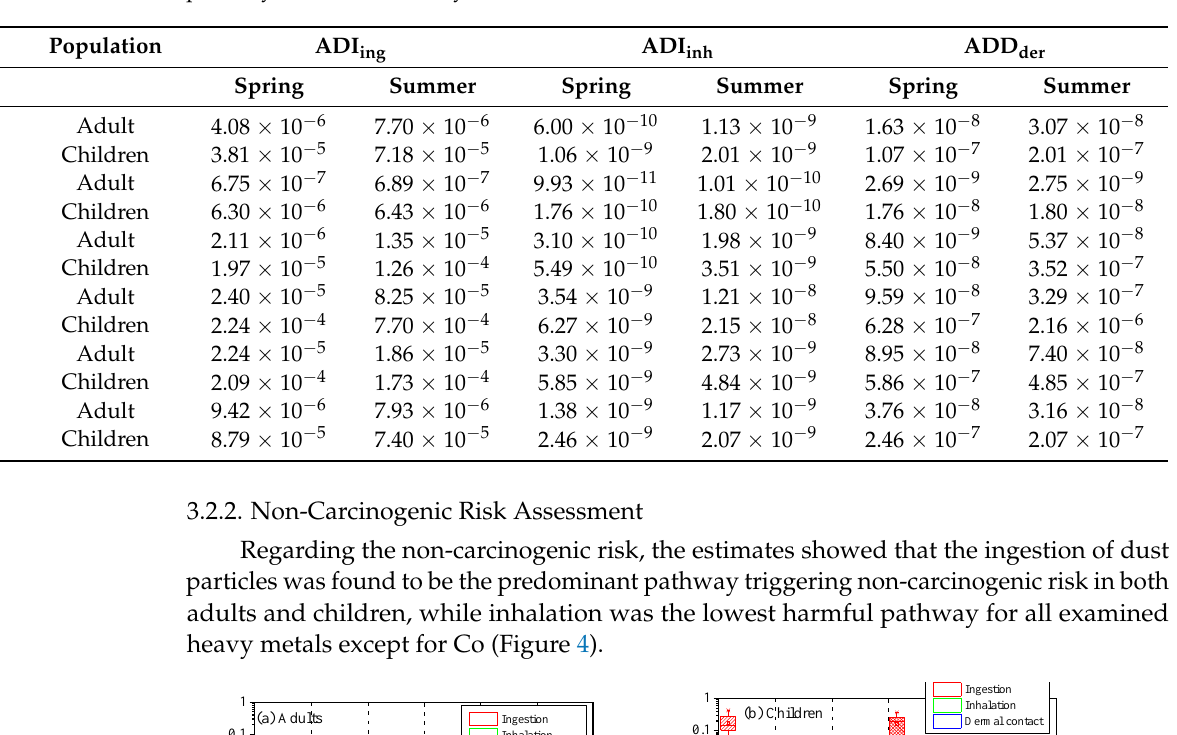
Table 2. Reference dose values of heavy metals for the ingestion, inhalation and dermal contact pathways used in this study.